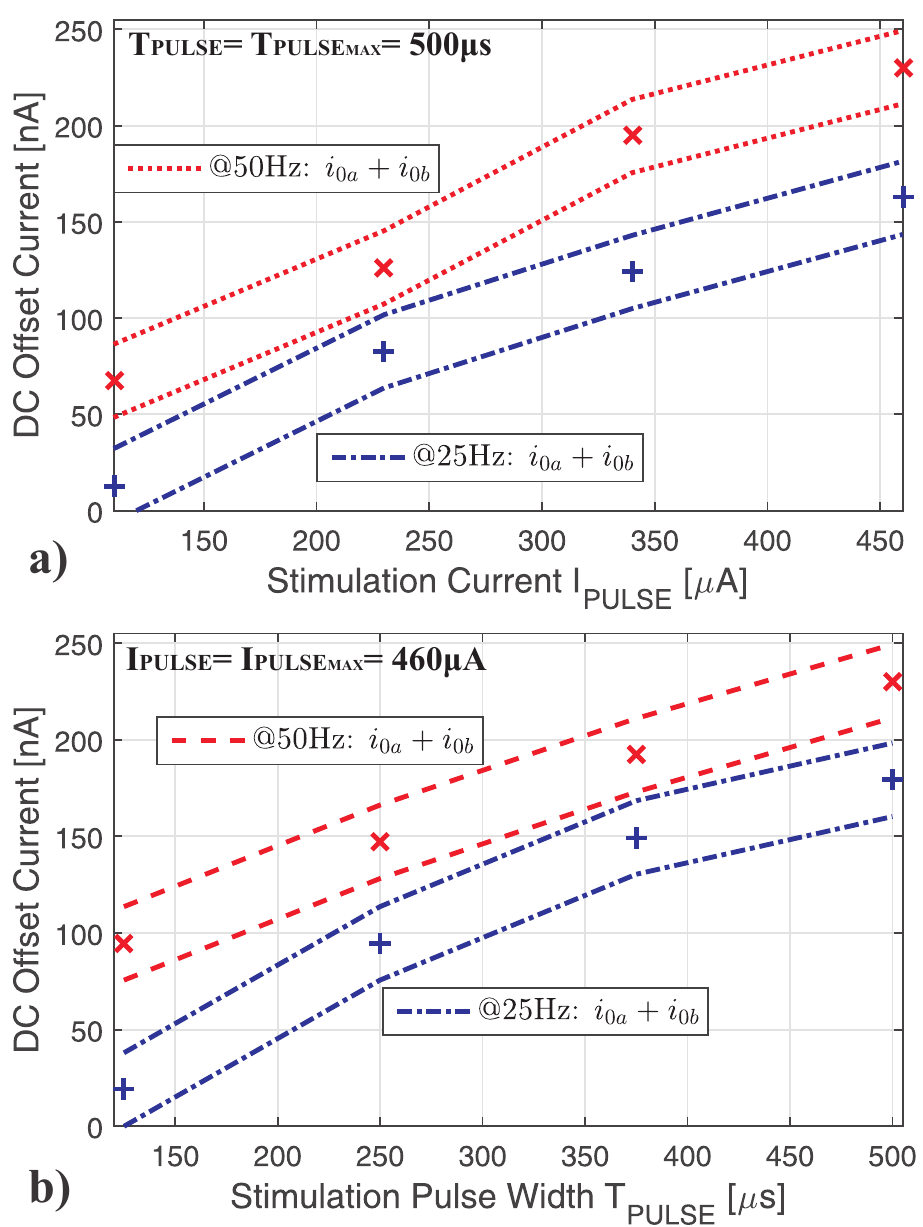
Figure 9. Hexagon HEXa and HEXb excitations according to the stimulation pattern in Figure 8. ( a ) Biphasic current amplitude I PULSE versus DC offset current ( ± 3 σ range around the average value defined by dashed and dash-dotted lines) for the Hex Quasi-monopolar (HQ) stimulation pattern at 50 Hz (see × ) and 25 Hz (see +). Pulse width constant equal to T PULSE = T PULSE ( b ) Biphasic pulse duration T PULSE versus DC offset current ( ± 3 σ range around the average value defined by dashed and dash-dotted lines) for the Hex Quasi-monopolar (HQ) stimulation pattern at 50 Hz (see × ) and 25 Hz (see +). Pulse amplitude constant equal to I PULSE = I PULSE